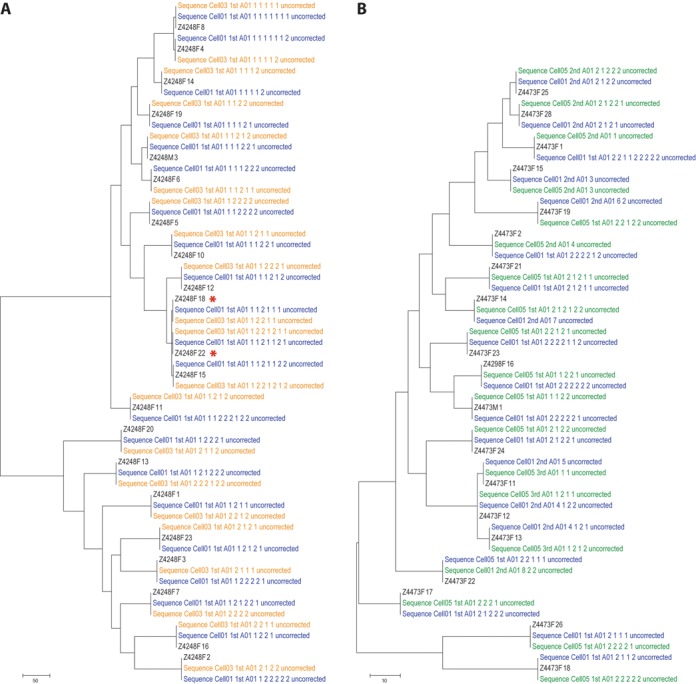
Comparison of the reference Sanger sequences with the consensus sequences generated by the algorithm. Maximum-parsimony trees were constructed using the Sanger reference sequences (labeled in black) for chronic patient Z4248F (A) and chronic patient Z4473F (B) and the consensus sequences obtained with the algorithms described here (labeled in blue for SMRTCell #1, in orange for SMRT Cell #3 and in green for SMRT Cell #5). The name of each consensus sequence denotes, in addition to the specific SMRT Cell, the round of analysis (first, second or third) and the ‘path’ indicating the subgroup in which the sequence was found. The ‘uncorrected’ label indicates that these are the consensus sequence obtained before implementing the INDEL correction algorithm.